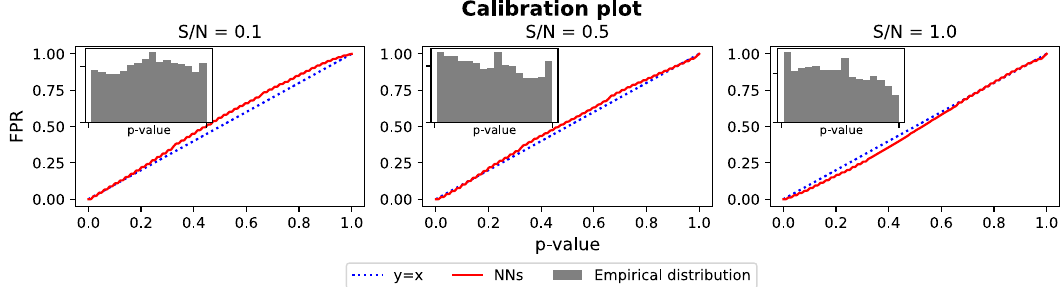
Fig. 5 Calibration plots of the proposed permutation for NNs on simulation datasets without interactions. Inner panels show that empirical distributions of p -values (with 50 random permutations) are uniform, and red lines show that the p -value from permutation is close to the corresponding false positive rate (blue dashed lines). This means the proposed permutation distribution for NNs interactions